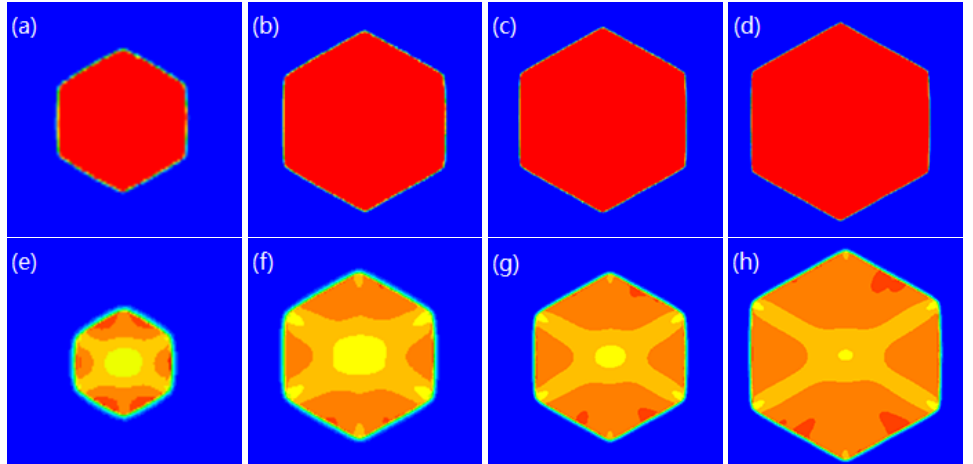
Figure 12. When K 0 = 0.8, under pure diffusion conditions, the simulated shape of spherulites and the corresponding temperature field distribution. (Under pure diffusion conditions, ( a – d ) is the crystalline morphology of the polymer, and ( e – h ) is the corresponding temperature field).